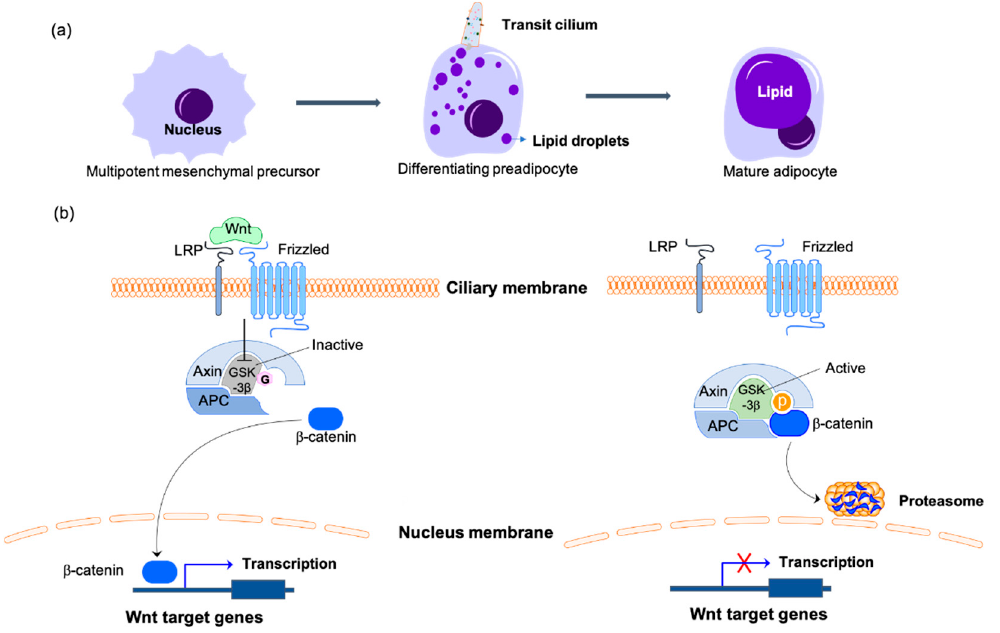
Figure Figure 2. Primary cilia-mediated Wnt/ β -catenin signaling in the regulation of adipogenesis. ( a ) Adipogenesis is the process of mesenchymal precursors committing to preadipocyte lineage cells then differentiating into mature adipocytes. Primary cilia are only present on the differentiating preadipocytes during this process. ( b ) On the differentiating preadipocytes, the binding of Wnt to the receptors of the ciliary membrane catalyzes the phosphorylation and inactivation of GSK3 β , thus inhibiting the phosphorylation of β -catenin. β -catenin is transported to the nucleus to initiate the transcription of Wnt target genes to inhibit the differentiation of preadipocytes. With Wnt missing or the primary cilium disassembling, the active form of GSK3 β phosphorylates β -catenin and promotes its degradation by the proteasome, which inhibits the expression of adipogenesis inhibitors and promotes the differentiation of preadipocytes. The O-GlcNAcylated molecules are labeled with pink hexagons. The phosphorylated molecules are labeled with orange circles. LRP, lipoprotein receptor- related protein; APC, adenomatous polyposis coli protein; GSK3 β , glycogen synthase kinase-3 β .